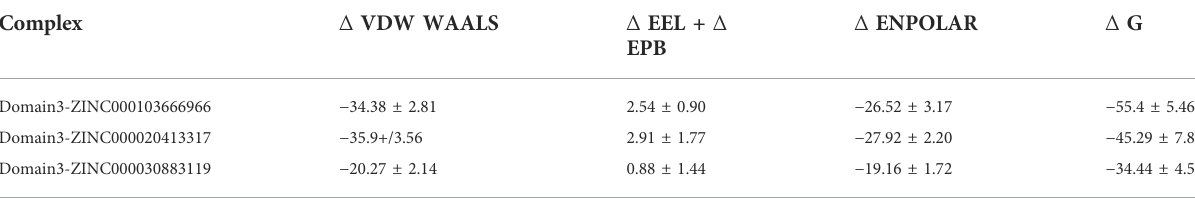
TABLE 5 Table showing the van der Waal, electrostatic + polar solvation, SASA, and binding energy in Kcal/mol of the complexes generated by MMPBSA. Complex Δ VDW WAALS Δ EEL + Δ